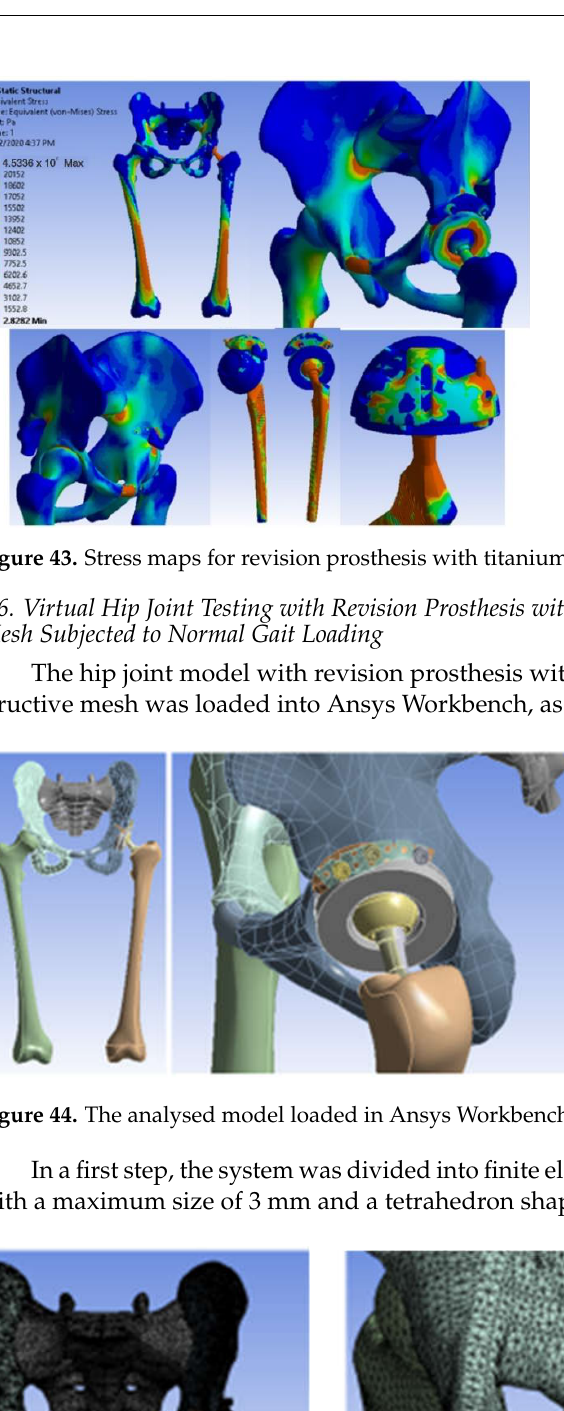
Figure 42. Strain map for revision prosthesis with titanium augment.